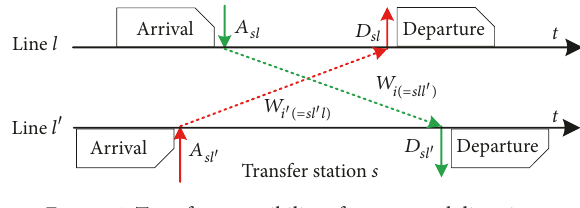
Figure 1: Transfer accessibility of two mutual